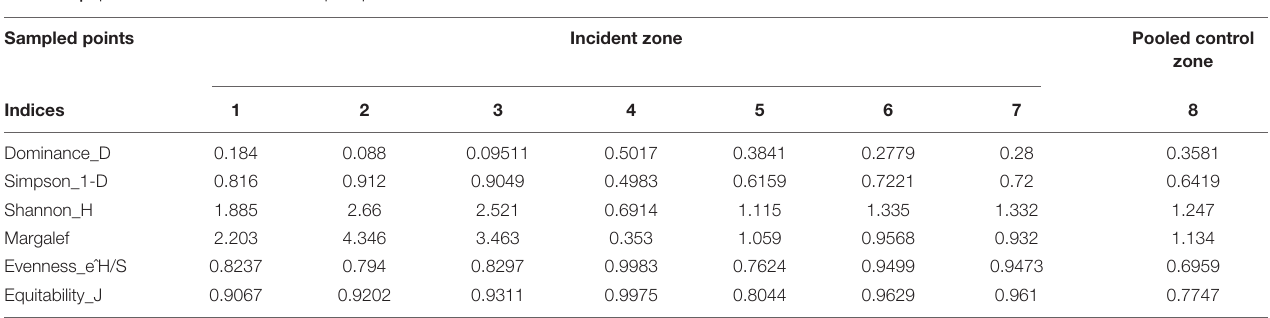
TABLE 3 | Species index table for the sampled points with in the studied area. Sampled